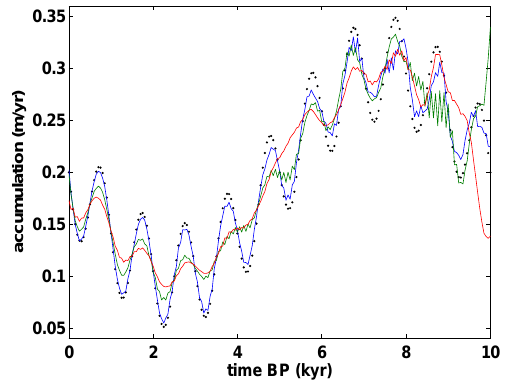
Figure 2. Recovered accumulation from the synthetic age–depth distribution obtained adding 1% (blue), 5% (green) and 10% (red) uniform noise to the solution derived from the reference accumulation (dotted line).